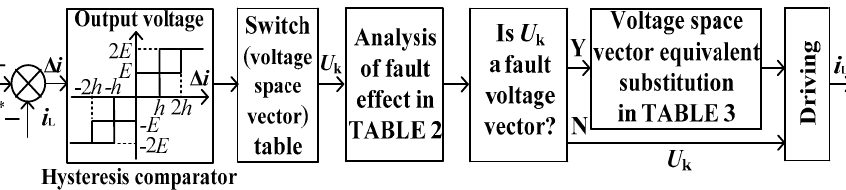
Figure 2. Diagram of current-tracking control based on current hysteresis comparator.